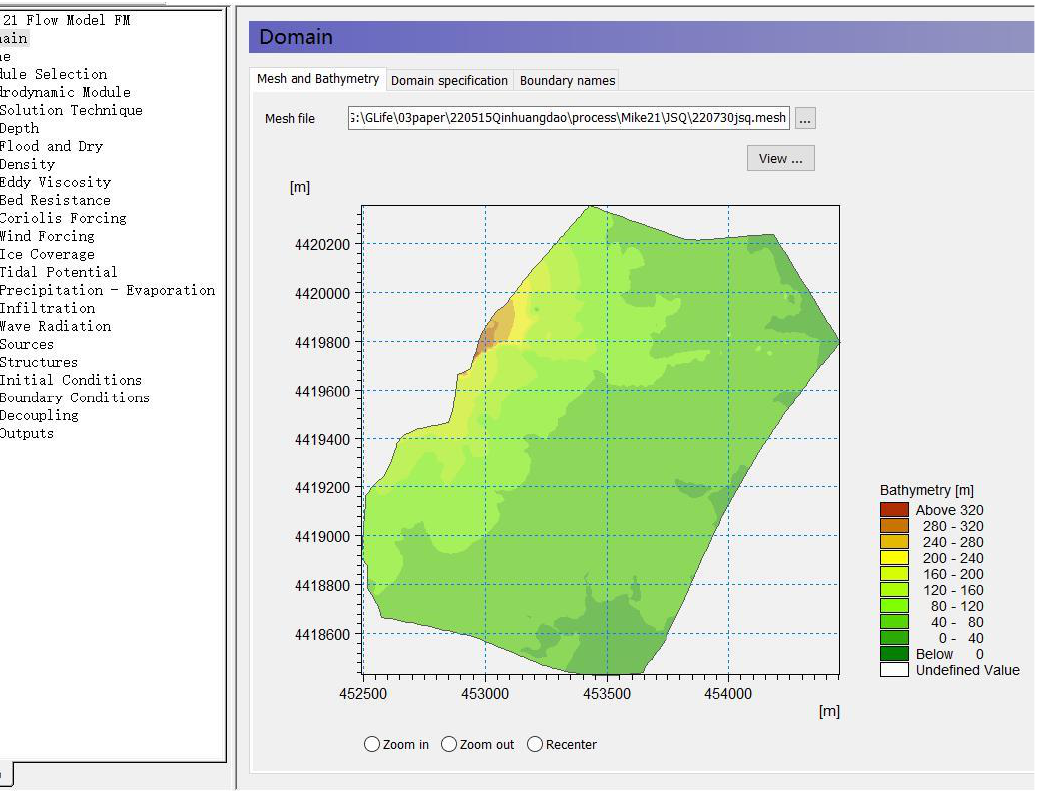
Figure 6. MIKE 21 model built before site construction. Notes: MIKE 21 Flow Model FM is a modelling system based on a flexible mesh